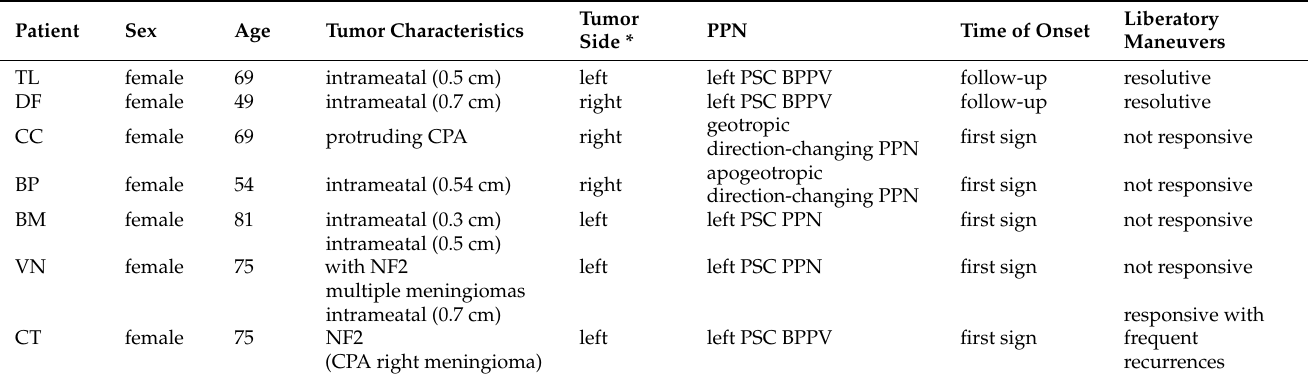
Table 1. Global characteristics of the patients. * Only the side with AN is reported. CT also has contralateral PSC PPN with a PCA meningioma (see Figure